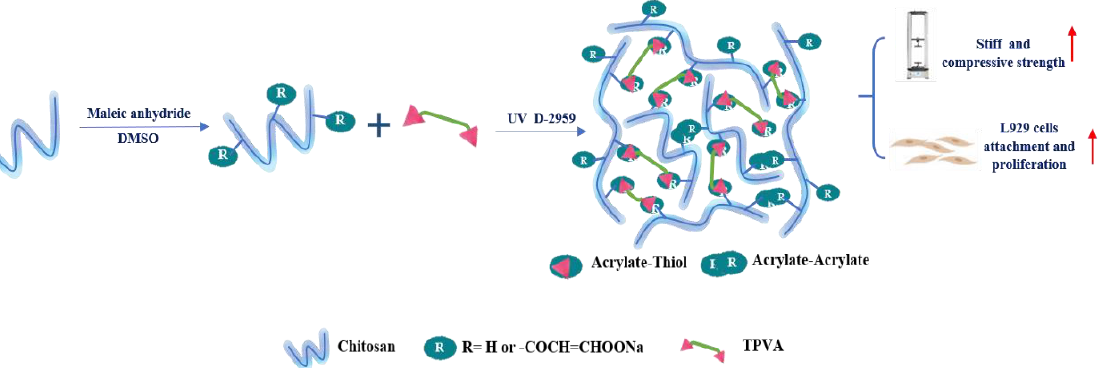
Figure 5. Reaction schematic and photobiology of MCS/TPVA hydrogels.